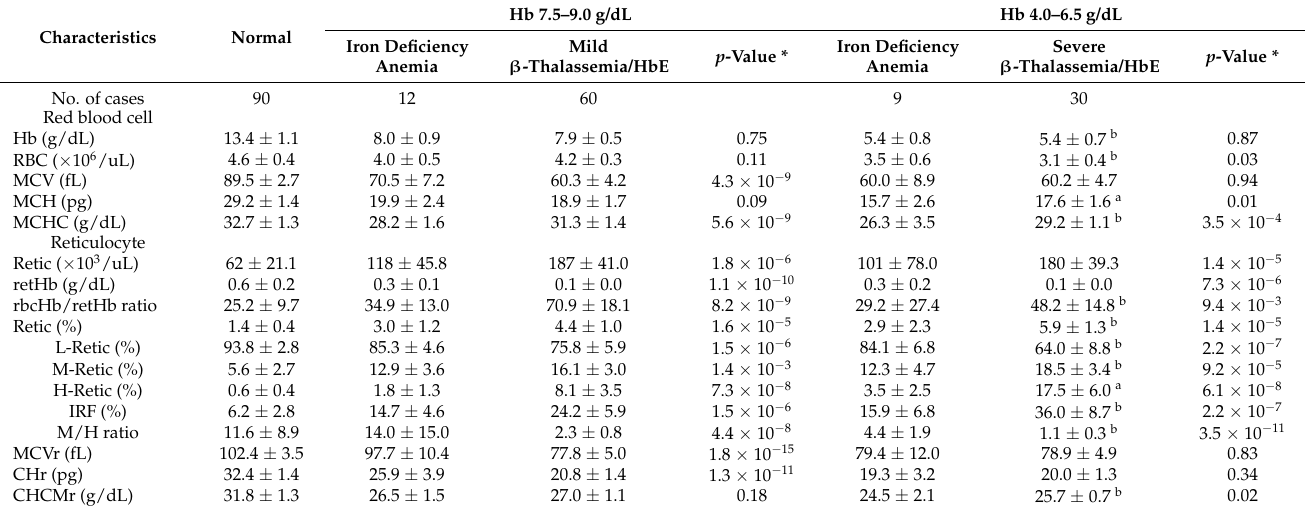
Table 1. Distribution of red blood cell and reticulocyte parameters in β 0 -thalassemia/HbE patients, iron deficiency anemia patients and healthy normal